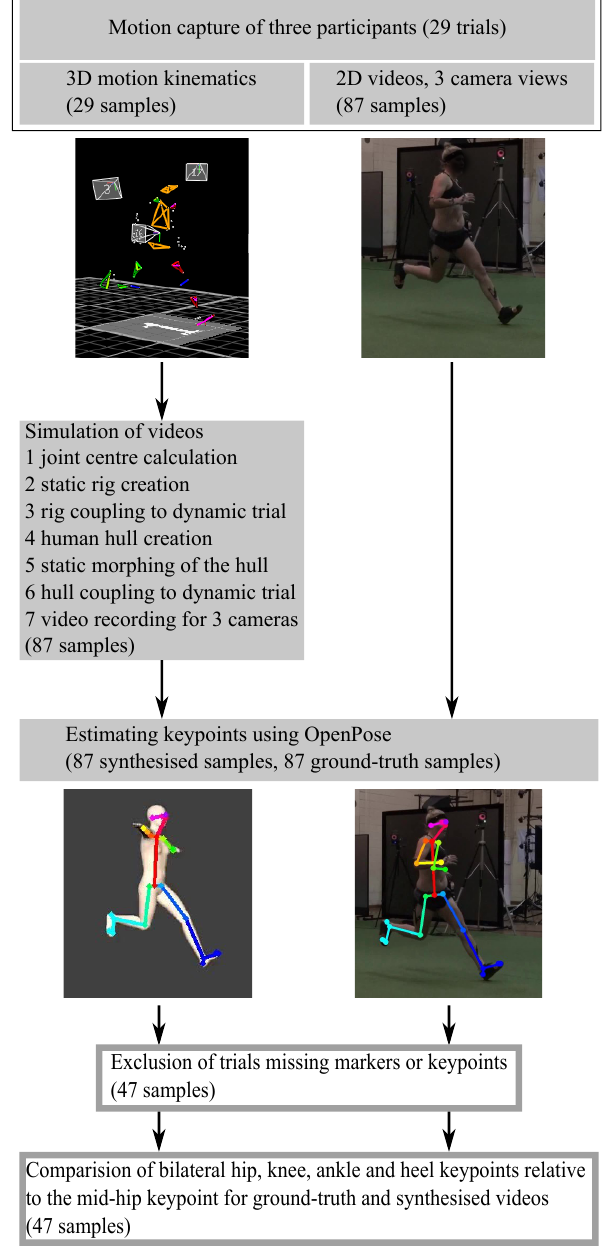
Figure 3. Design overview of the synthesised 2D video method validation study; 3D motion trajectory data from three participants was used for validation. Synthesised 2D videos showing errors identified by visual inspection, such as body segments following unachievable movement trajectories, or those missing pose model estimated keypoints were